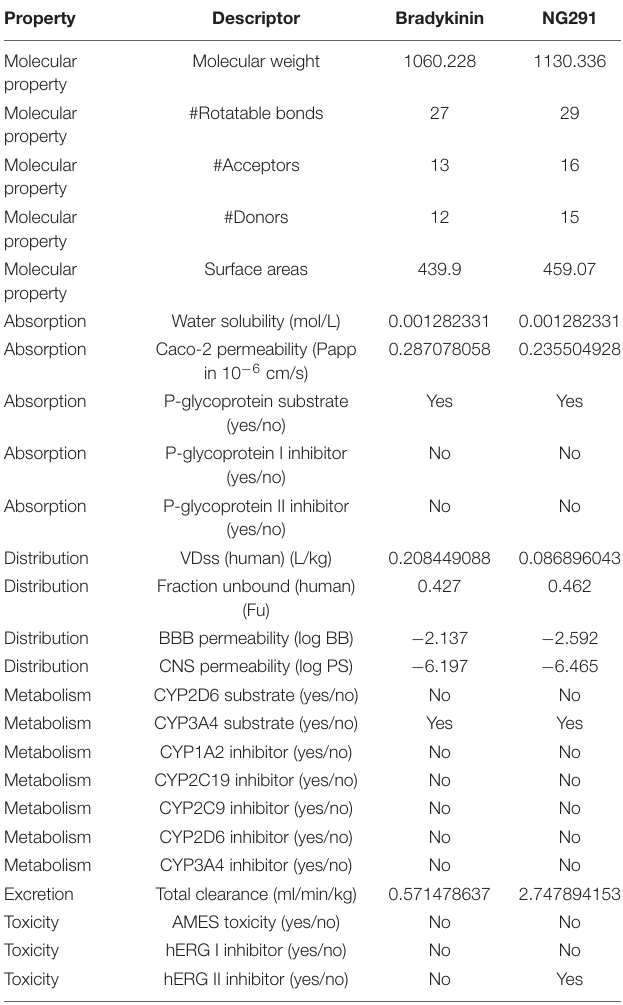
TABLE 1 | Predicted pharmacokinetic properties of bradykinin and